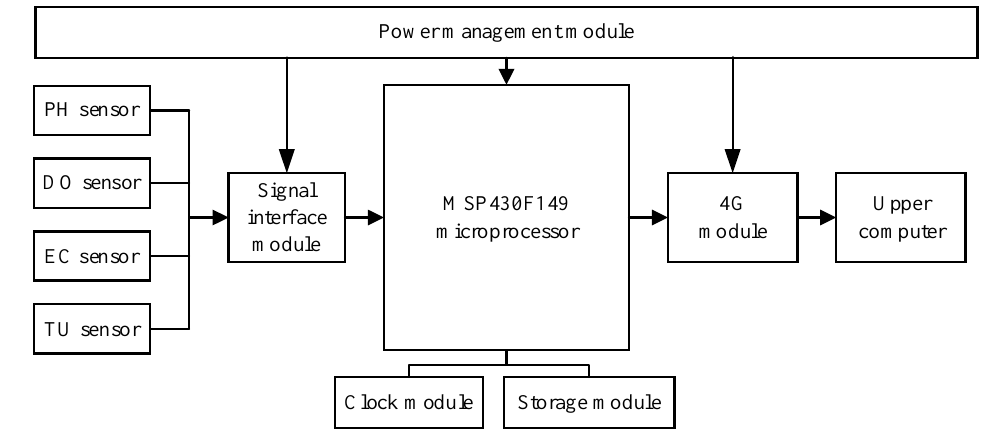
Figure 13. Hardware circuit architecture diagram of the COD online estimation system.